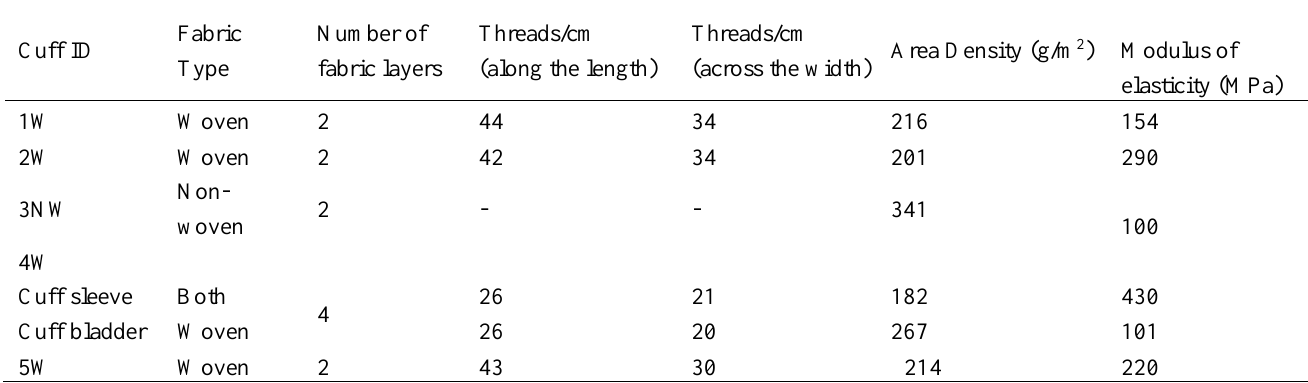
Specifications of the cuff